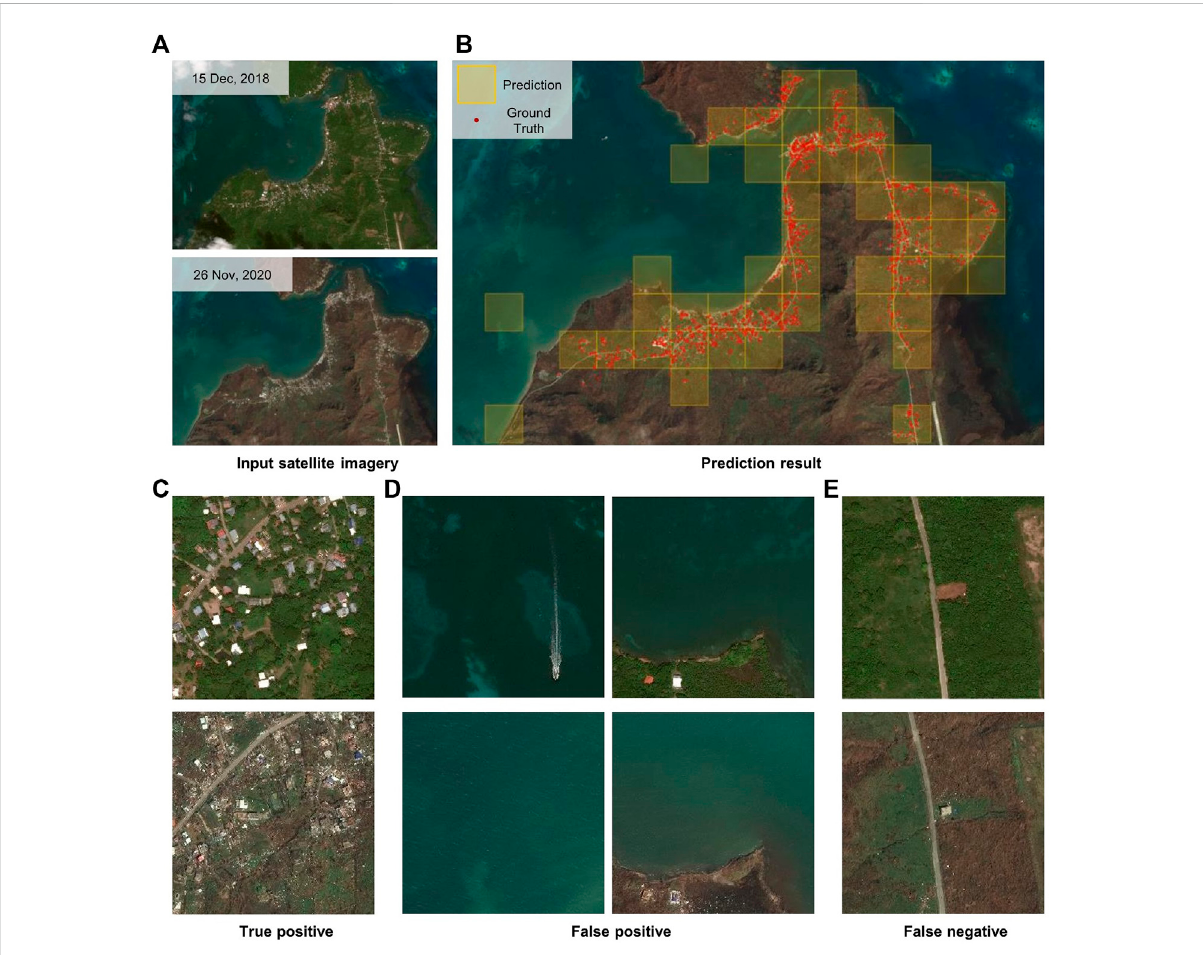
FIGURE 6 The prediction result of our model on Providencia Island, Colombia. (A) shows the input satellite imagery captured on 15 December 2018, and 26 November 2020. (B) shows the result of our model. The red dot is the point of damaged buildings in the UNOSAT ground truth data, and the yellow box indicates the grid where our model reports damage. The zoomed grids of true positive, false positive, and false negative cases are shown in (C – E) ,